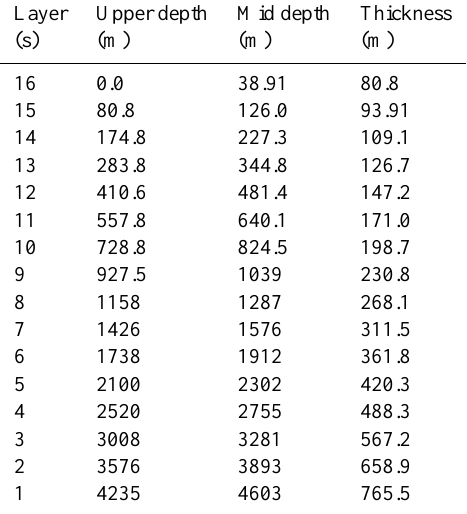
Table A4. : Depths and thicknesses associated with ocean layers in the “biogem”, 3636s16l, 3660l16l and 6432i16l